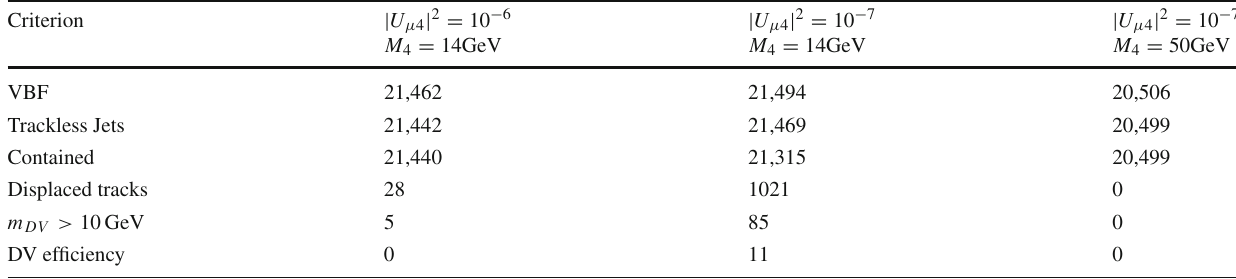
Table 6 Cut flow for the displaced jet search in the minimal model, for several benchmarks. We have 10 5 initial events. Contained events are those where the heavy neutrino decays within the tracker. The events